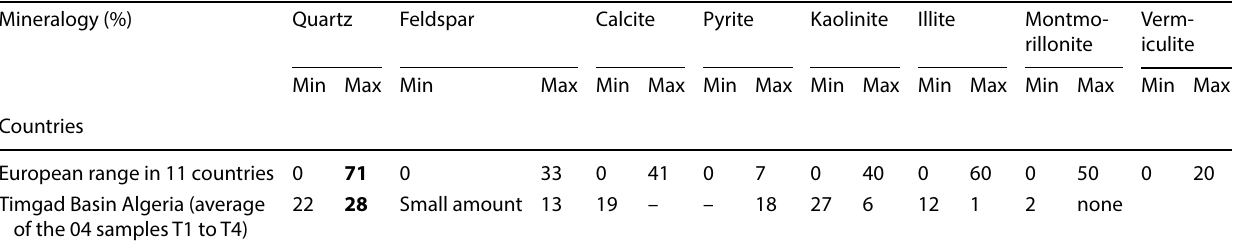
Table 5 Ranges of mineralogical compositions of clay raw materials used in the brick and tile industry in in 11 European countries (Austria, France, Netherlands, Hungary, Italy, Greece, Denmark, Belgium, UK, Switzerland, Germany) (European Commission 2007) [30] Mineralogy (%)